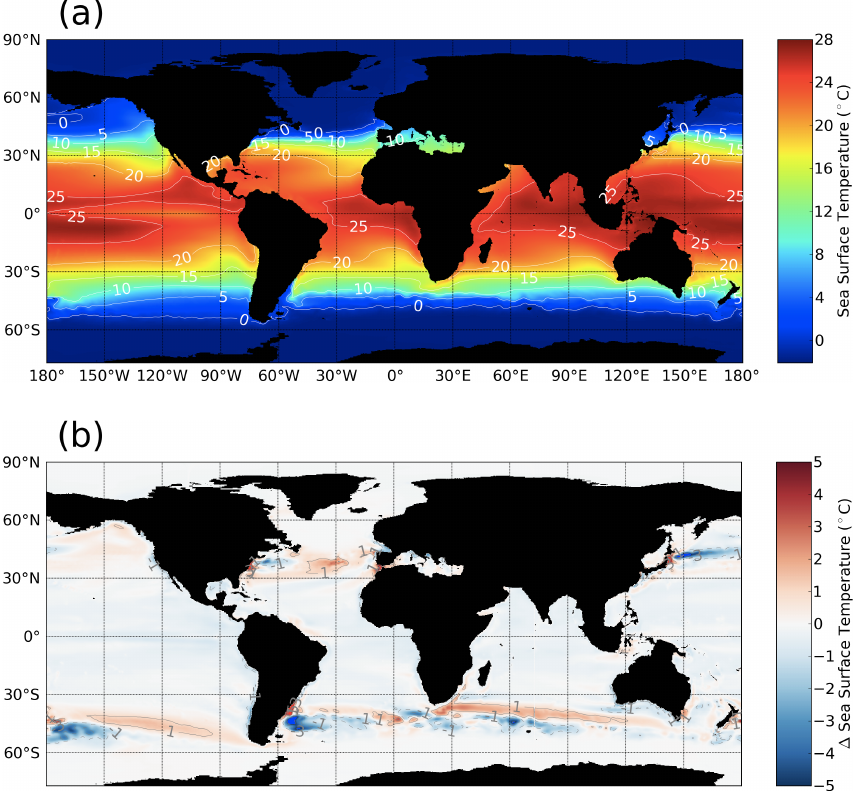
Fig. 1. Map of (a) the annually averaged sea surface temperature (SST) in the LGM eddy-permitting simulation and (b) the difference between the coarse resolution and the eddy-permitting simulation. Units in ◦